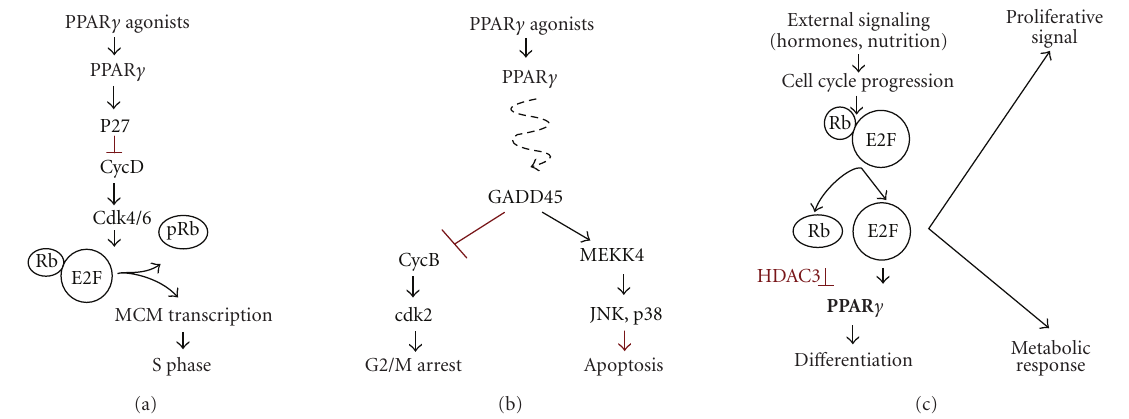
Figure 3: PPAR γ e ff ects in cancer cells. (a) The induction of Cdk inhibitor, p27 causes growth arrest due to reduced MCM7 activity and subsequent blockade of replication. (b) The induction of GADD45 impairs Cyclin B and causes G2M growth arrest. In addition, the activation of JNK and p38 kinases via MEKK4 initiates cell death by apoptosis. (c) PPAR γ activation by hormones and nutrition in normal cells and by agonists in cancer cells may activate the di ff erentiation